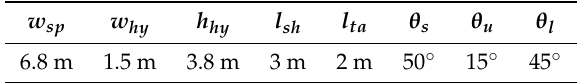
Figure 2. Scenarios of top-coal caving. The read and green particles are, respectively, the rock and coal. ( a ) In the initial scenario, the windows are closed. ( b ) In the second scenario, the particles collapse under the gravity. ( c ) In the final scenario, the windows close regulated by a given mechanism. There are five hydraulic supports simplified to the top-beam, shield-beam, and tail-beam. The tail-beam can rotate around the bottom of shield-beam with the given speed, and the scope shown in Table 1. Table 1. Parameters of 3D top-coal caving simulation